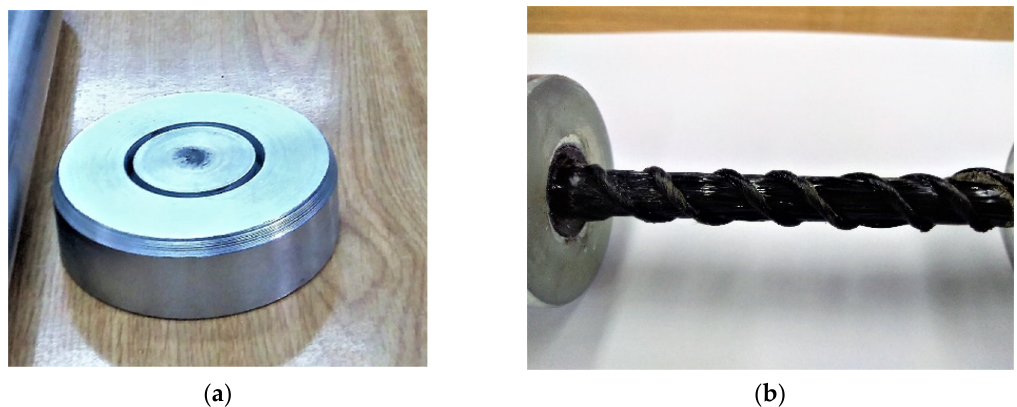
Figure 8. Attachment of the samples: ( a ) Lower circular steel plate for centering the sample; ( b ) anchor sleeves.